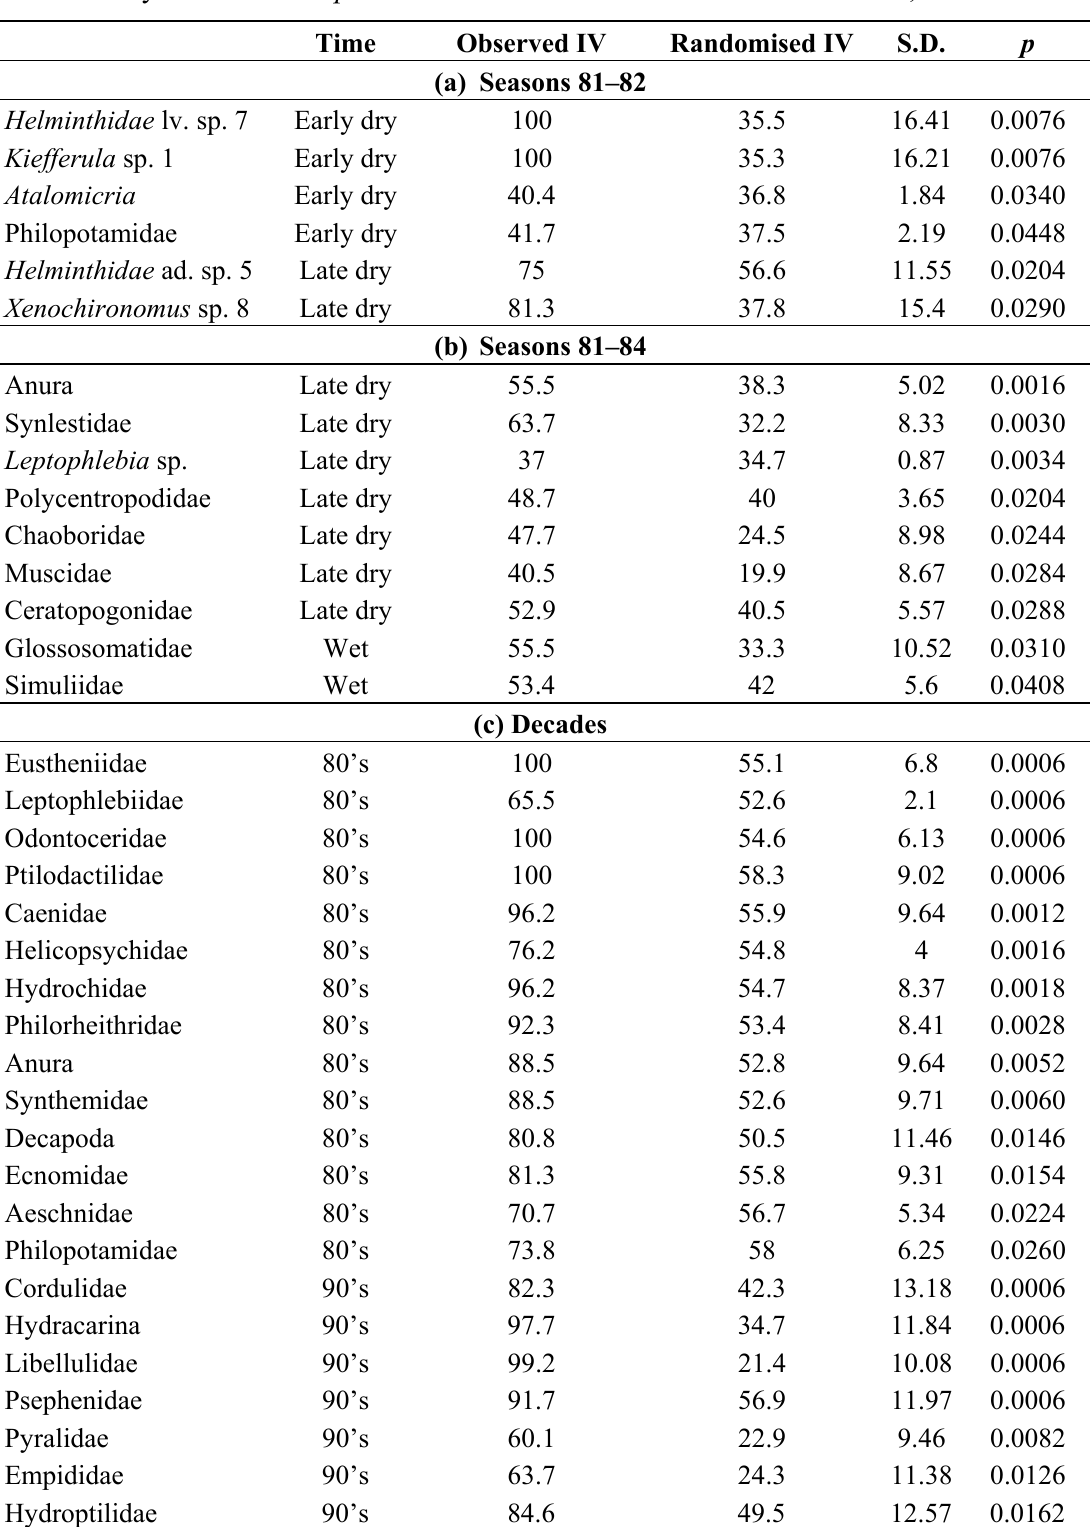
Table 3. Indicator values (IV) from indicator species analyses of groups of samples ( a ) from different seasons in 1981–1982; ( b ) from different seasons in 1981–1984; and ( c ) from the two decades. Only taxa for which p < 0.05 are shown. Abbreviations: “lv.” = larvae; “ad.” =